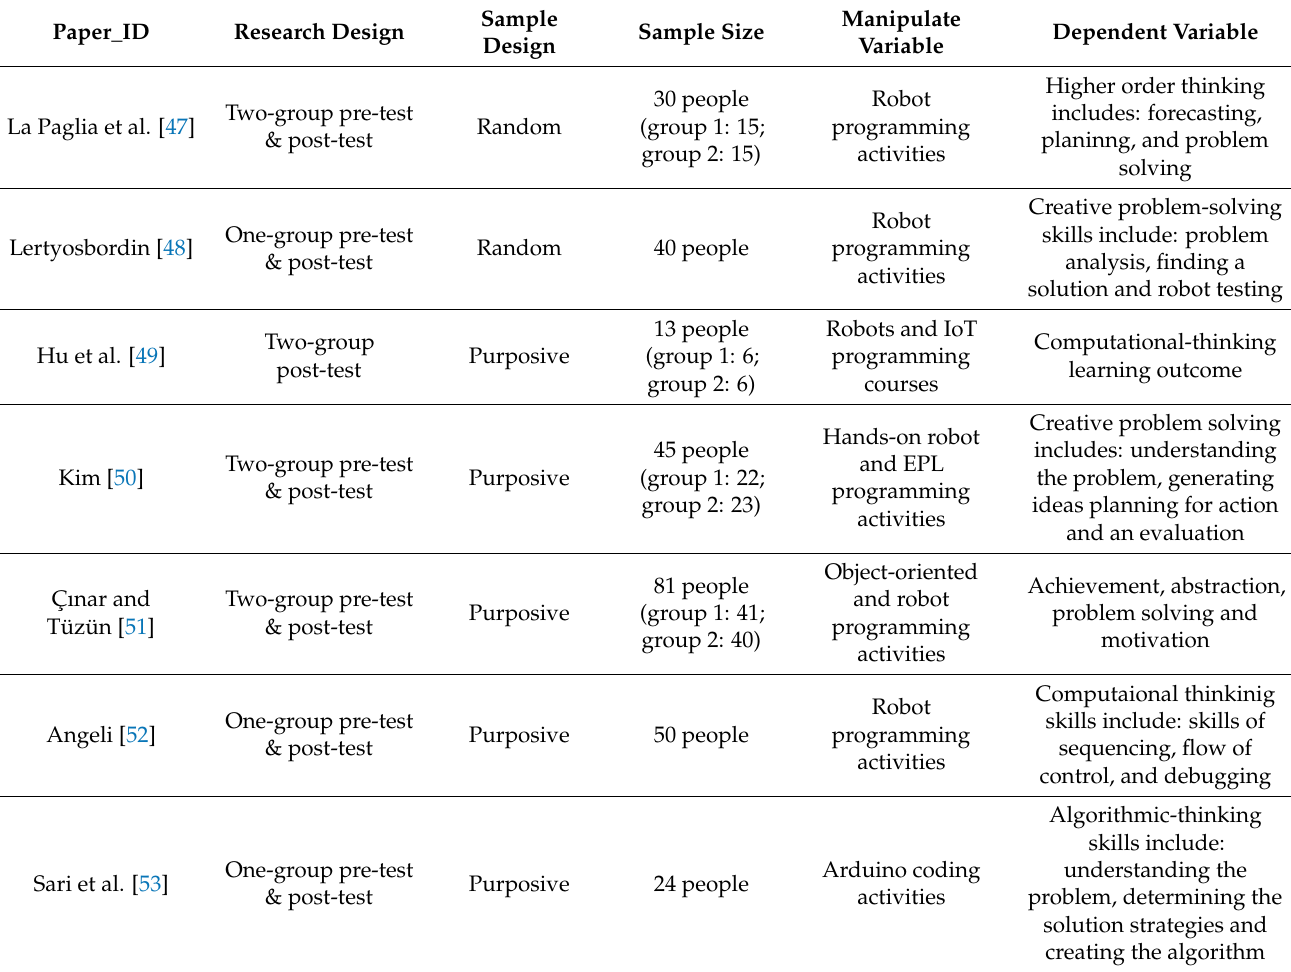
Table 5. Research design